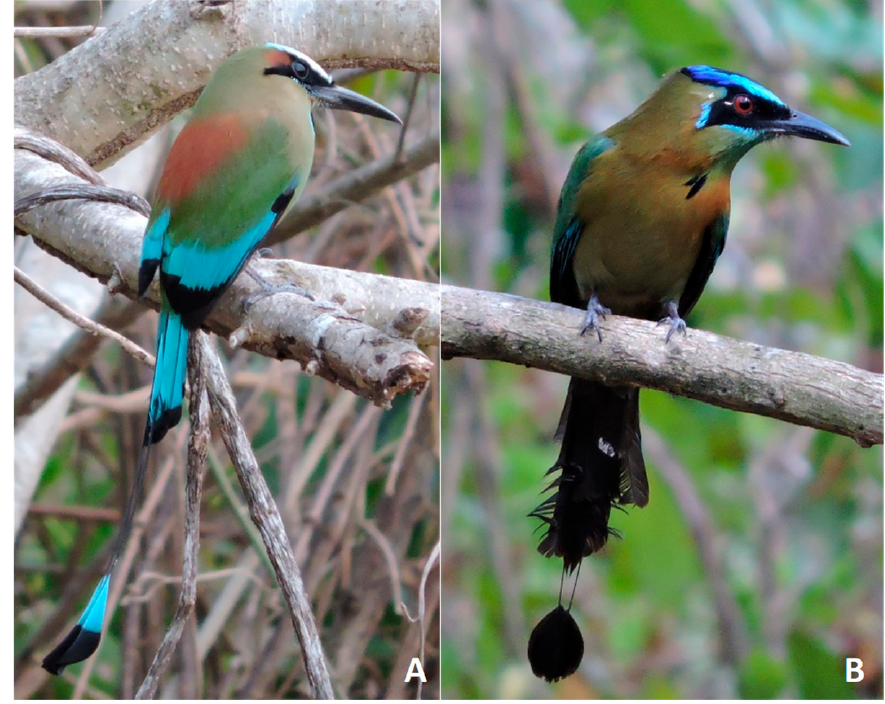
Figure 1. The study’s two target species in the Karen Mogensen Wildlife Refuge, observed at different sites: ( A ) Eumomota superciliosa ; and ( B ) Momotus lessonii . (Ph: M. Dal Zotto).